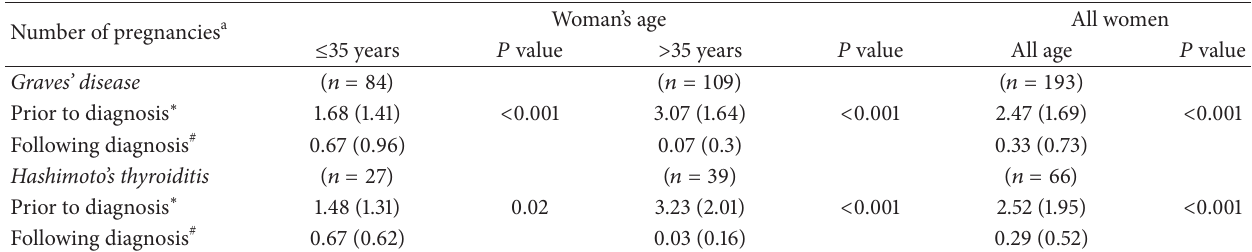
Table 3: Comparative analysis of the mean number of pregnancies prior to and following diagnosis of GD and HT in accordance with the woman’s age at diagnosis.